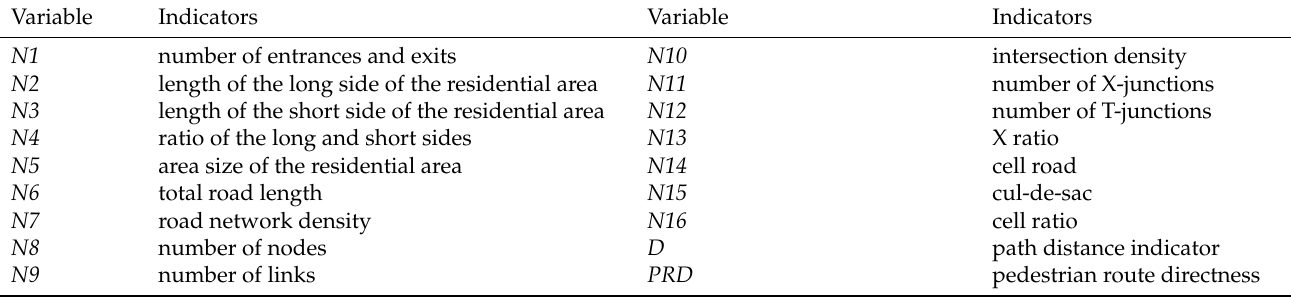
Figure 2. Framework plot of analysis process and method. Table 2. Variables for built environment indicators and road connectivity